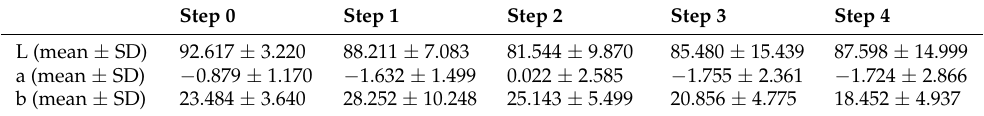
Figure 4. Values of ∆E for all groups and steps.